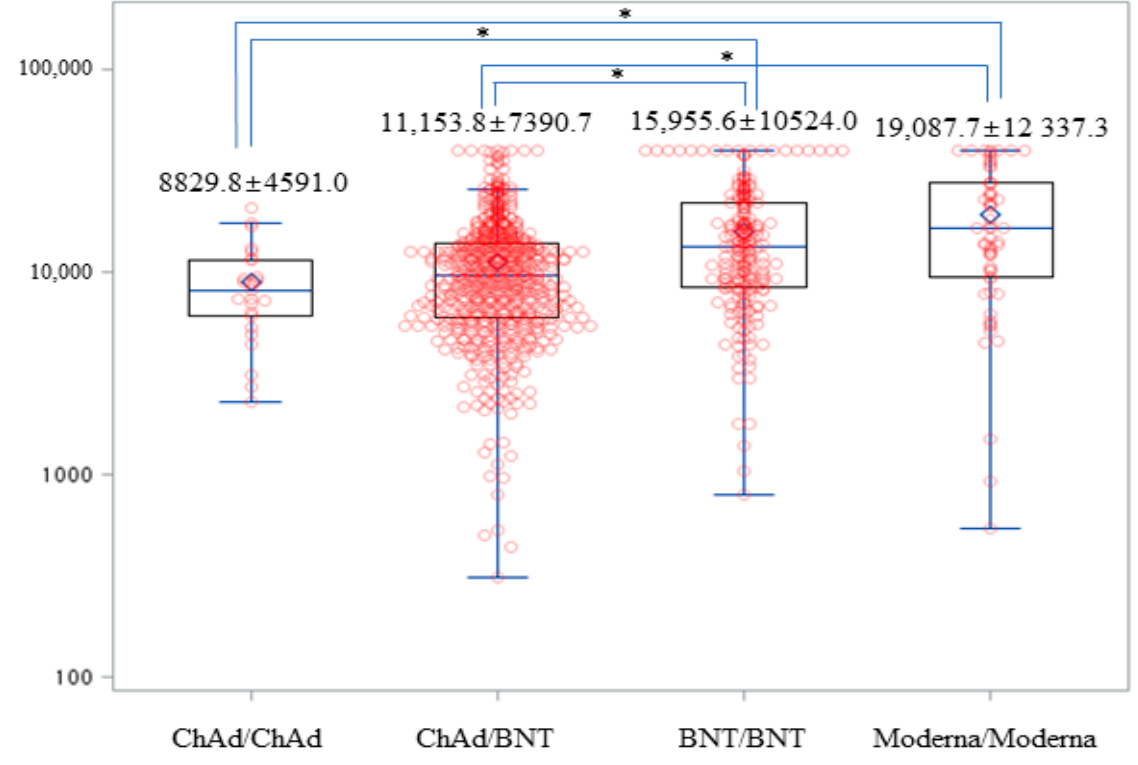
Figure 2. Anti-SARS-CoV-2 S-RBD IgG levels at T3-1 by vaccination type ( p < 0.001). * p -values ( p < 0.01) were calculated by a post-hoc analysis using Scheffe’s test: ChAd/ChAd, ChAd/BNT < BNT/BNT, and Moderna/Moderna.